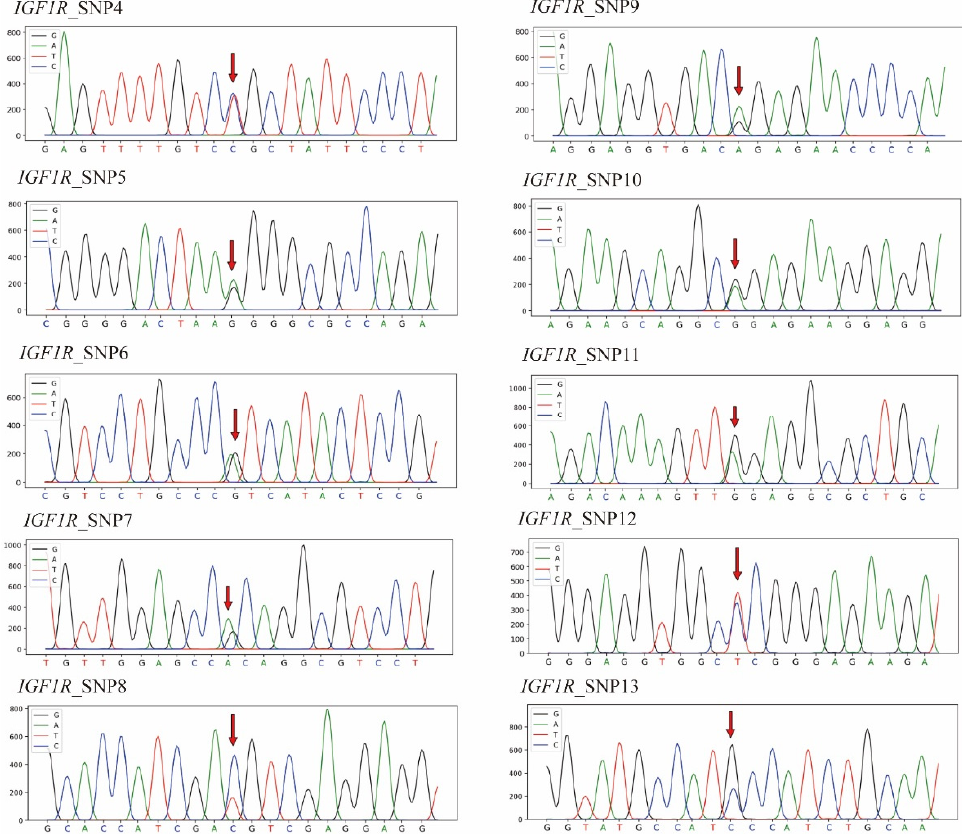
Figure 2. The sequencing peak maps for the ten detected SNP loci of the IGF1R gene in Hulun Buir sheep. SNP4: c.244C>T; the arrow denotes to the C–T mutation site. SNP5: c.714G>A (rs162159917); the arrow demonstrates the G–A mutation site. SNP6: c.924T>C (rs161166969); the arrow indicates